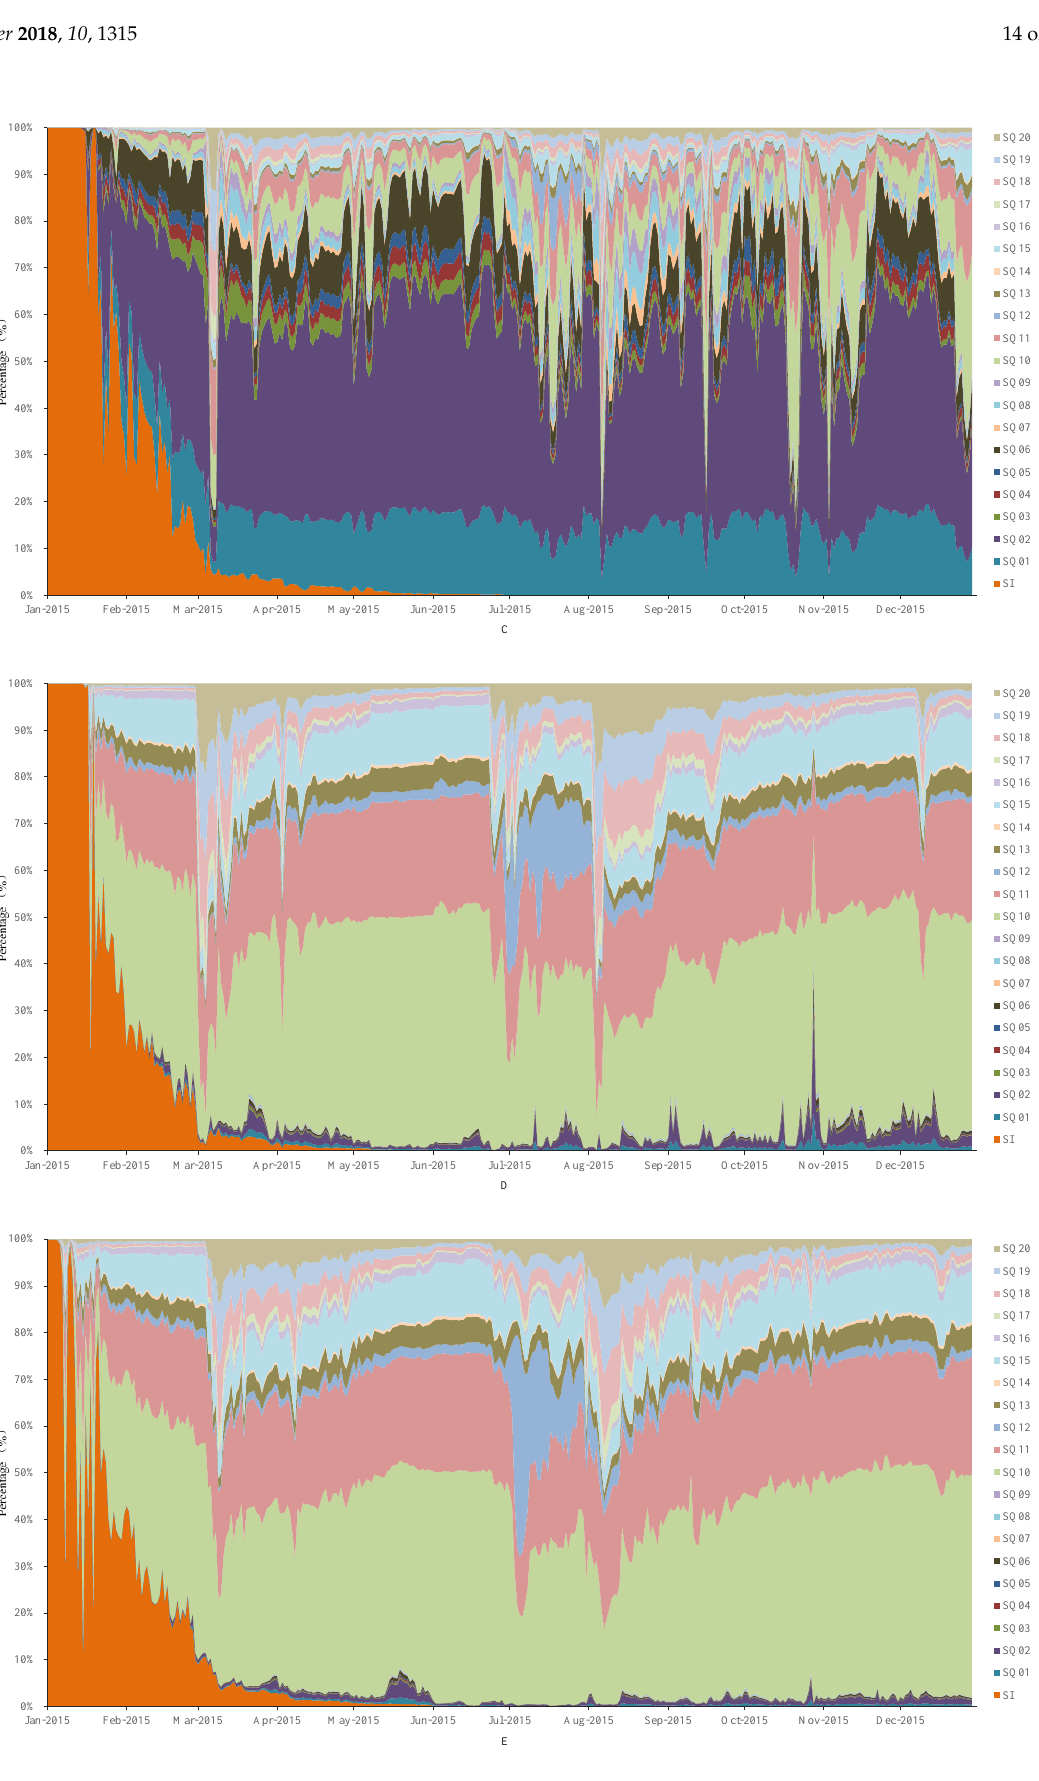
Figure 6. Source contributions to TP pollution at five monitoring points ( A – E ) in Lake Bali.